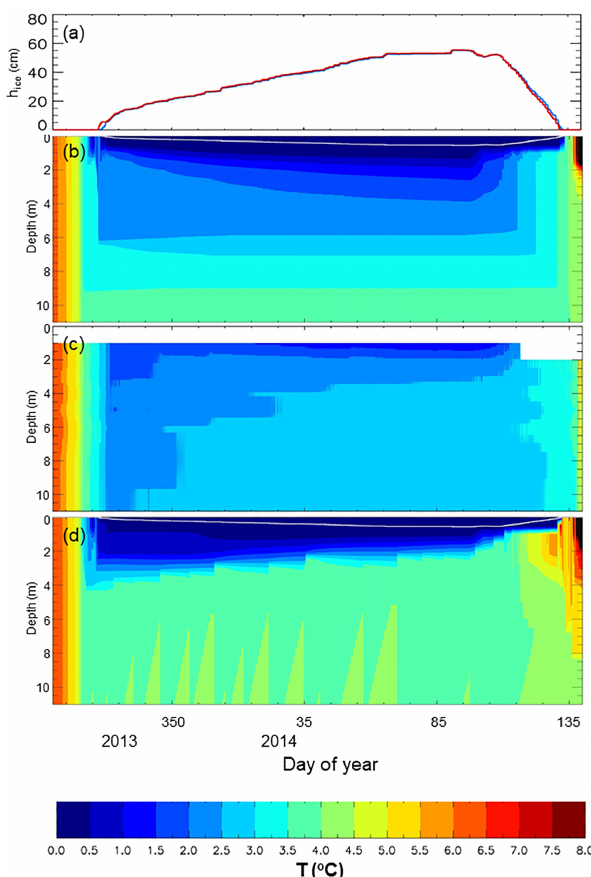
Figure 7. Simulated ice thickness (a) , and simulated (b) (d) and ob- served (c) temperature profiles for 1 November 2013–20 May 2014. The standard simulation (MacKay et al., 2017) is shown in (b) and the blue curve in (a) . Simulation X2 is shown in (d) and the red curve in (a)